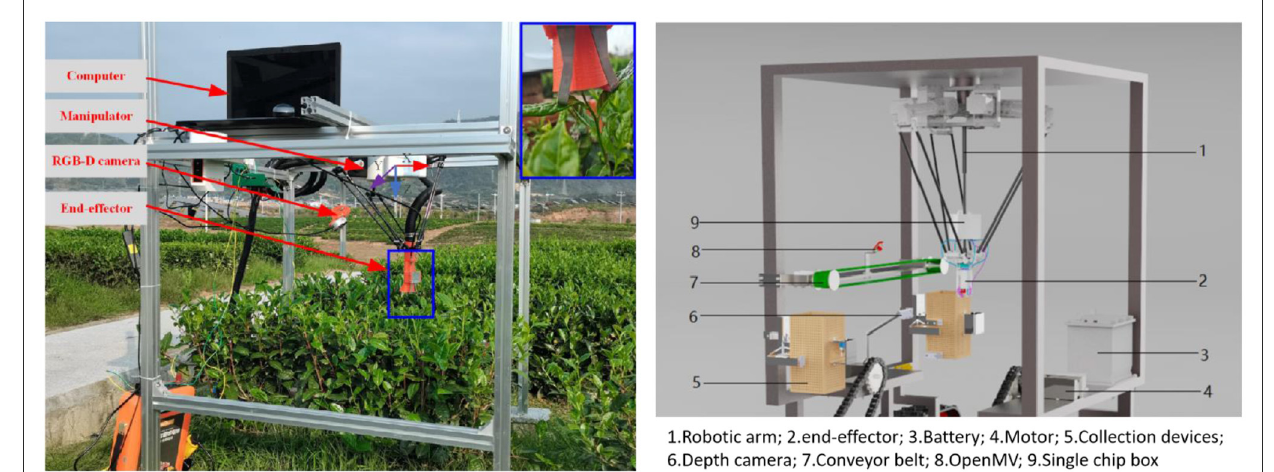
FIGURE5 Vision-based automatic tea picking machine, reproduced from Li Y. et al. (2021) and Chen et al.